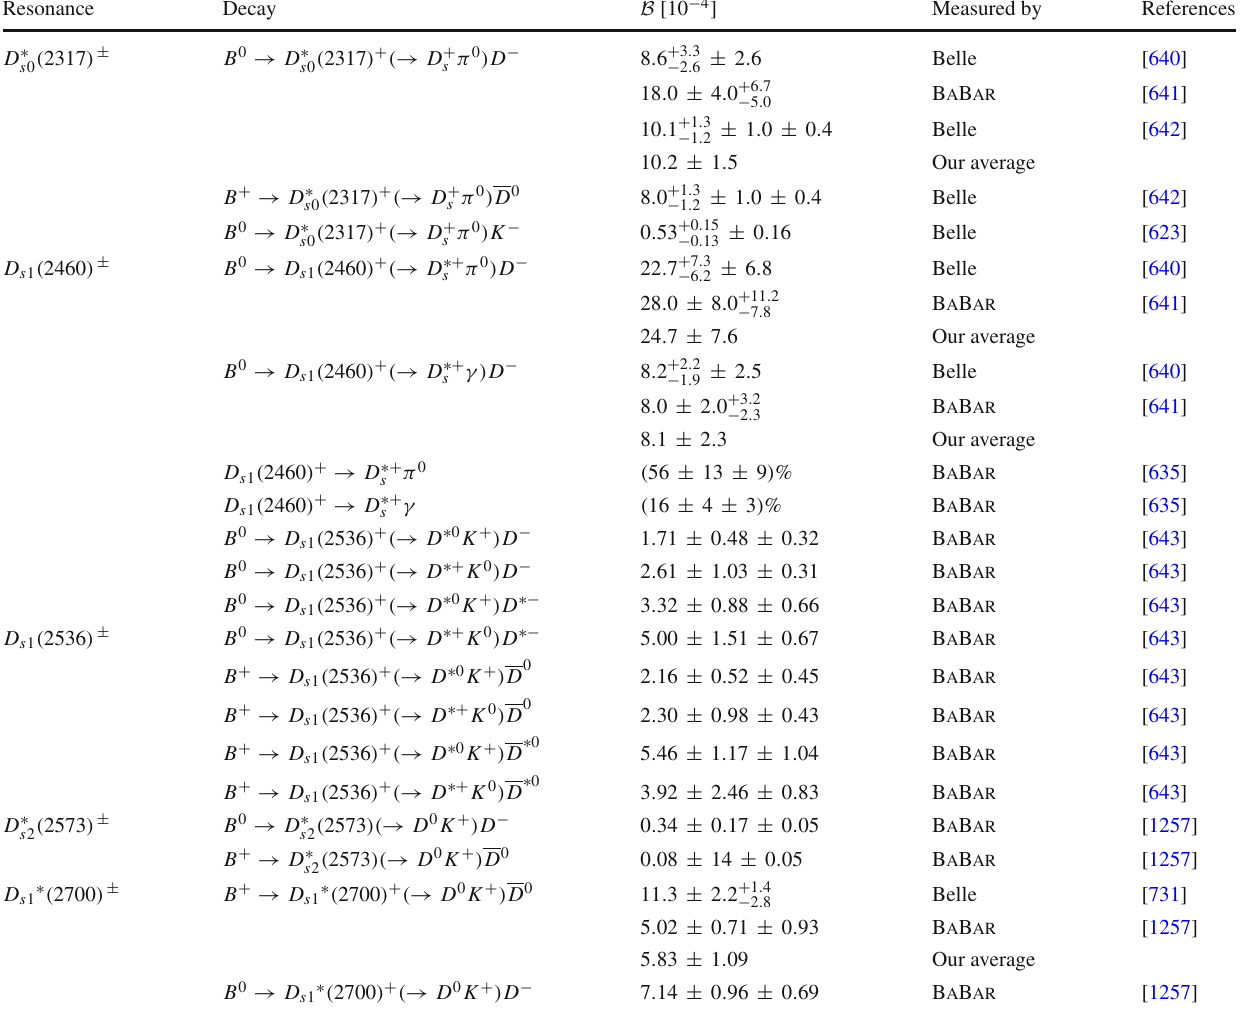
Table 293 Product of B meson branching fraction and (daughter) excited D s meson branching fraction Resonance